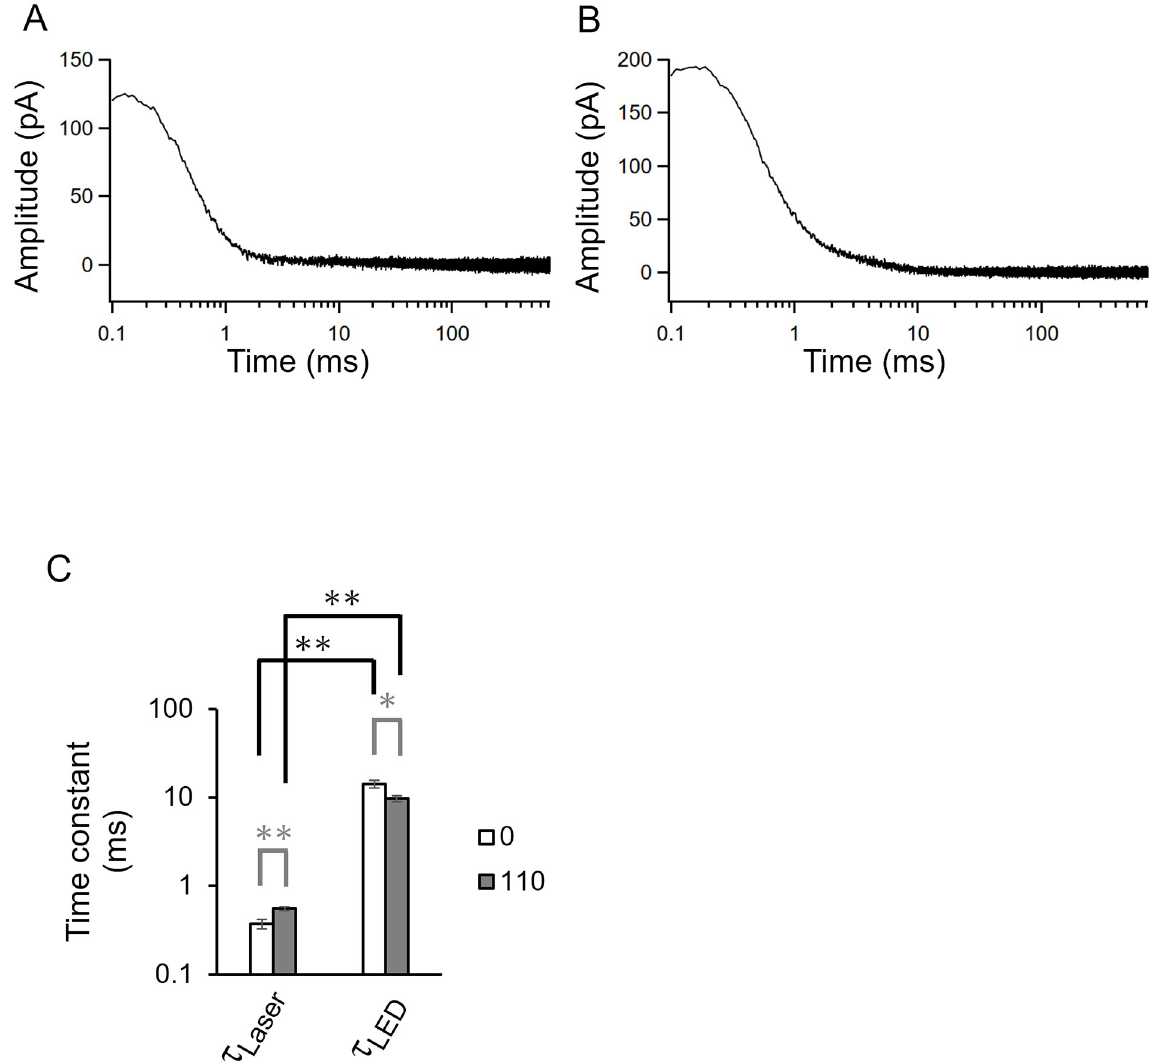
Fig 5. Single photocycle ion transport. Photocurrent of KR2 evoked by a 5 ns flash laser (532 nm) at 0 mV. The recording was performed in the absence (A) and presence (B) of intracellular Na + (110 mM) at pH i 7.4, while bath solution contained 140 mM NaCl at pH 7.4. C, Off- kinetics values obtained from a flash laser ( τ off Laser ), a green LED ( τ off LED ) (n = 7–16, � p < 0.05, �� p < 0.01). Open bar, in the absence of intracellular Na + . Gray bar, in the presence of 110 mM NaCl inside.